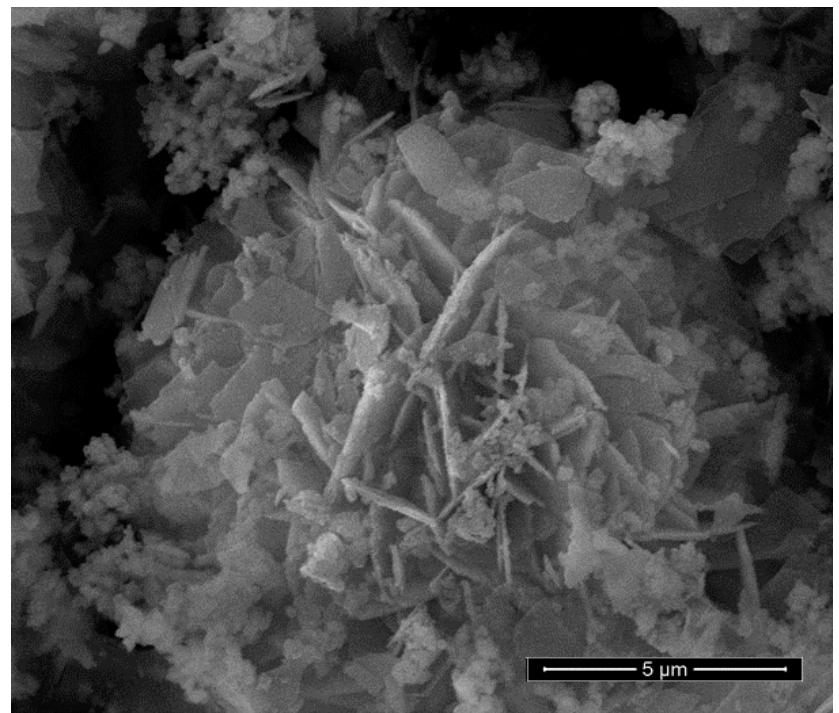
Figure 4. SEM image of the synthesized Ce-LDH, synthesized through HMT-driven homogeneous